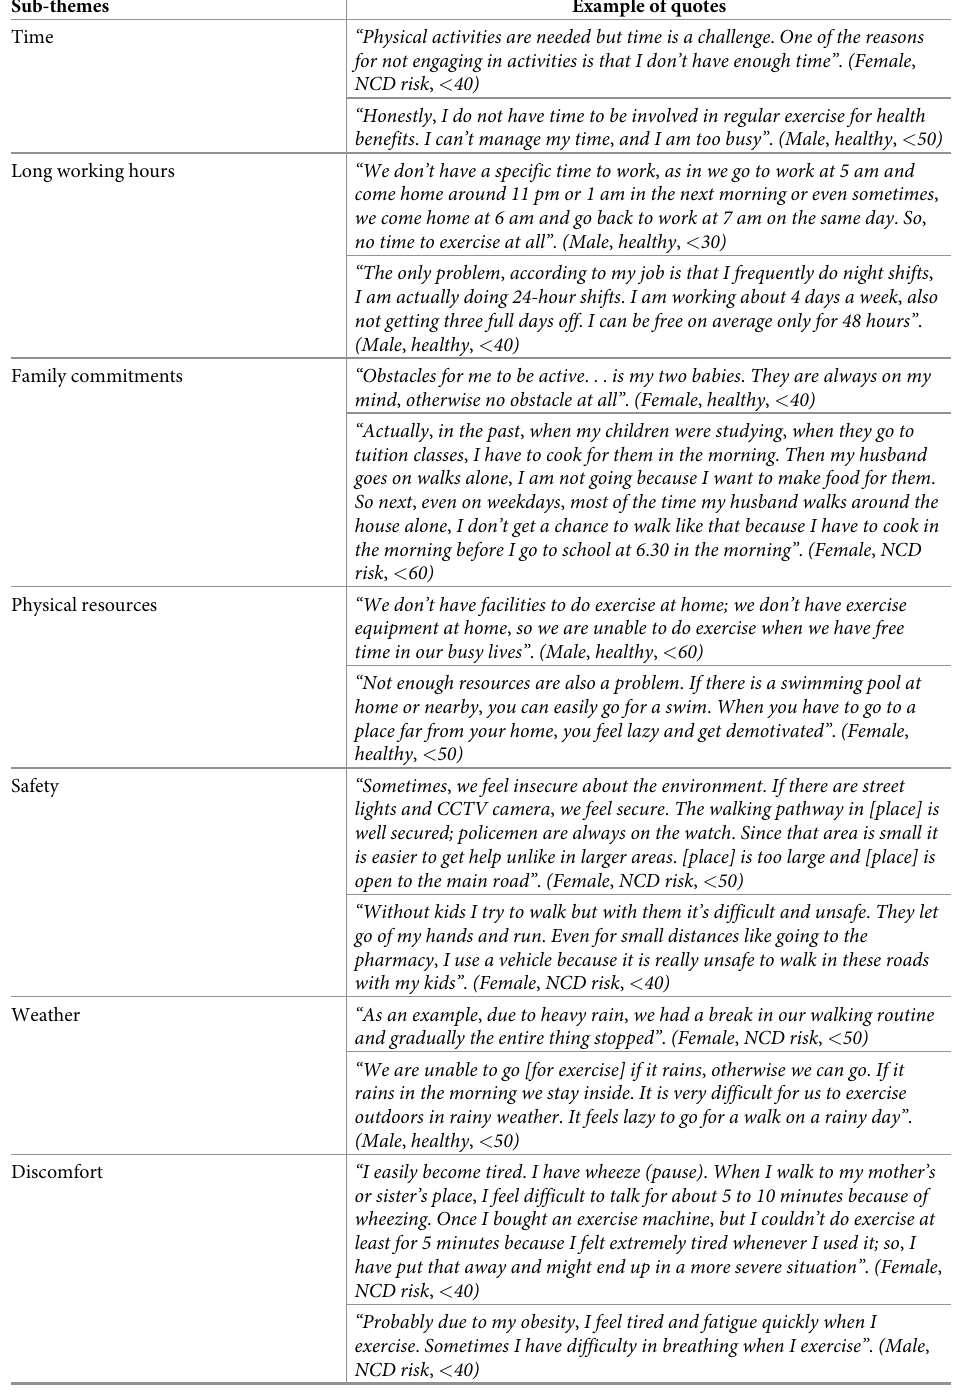
Table 2. Sub-themes on barriers for physical